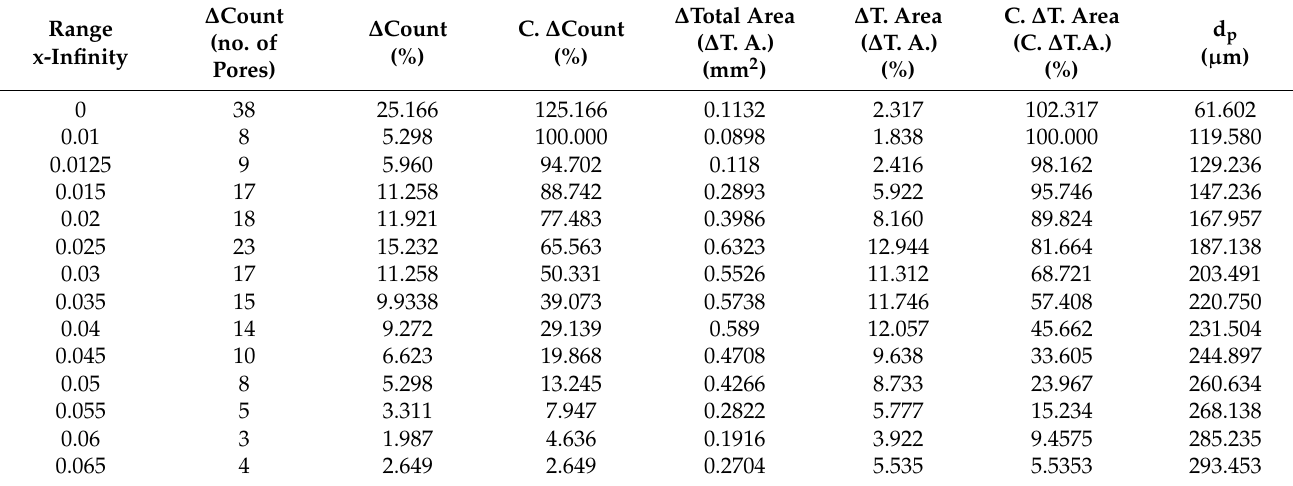
Table 2. Calculation of porosity parameters based on measurements in Table